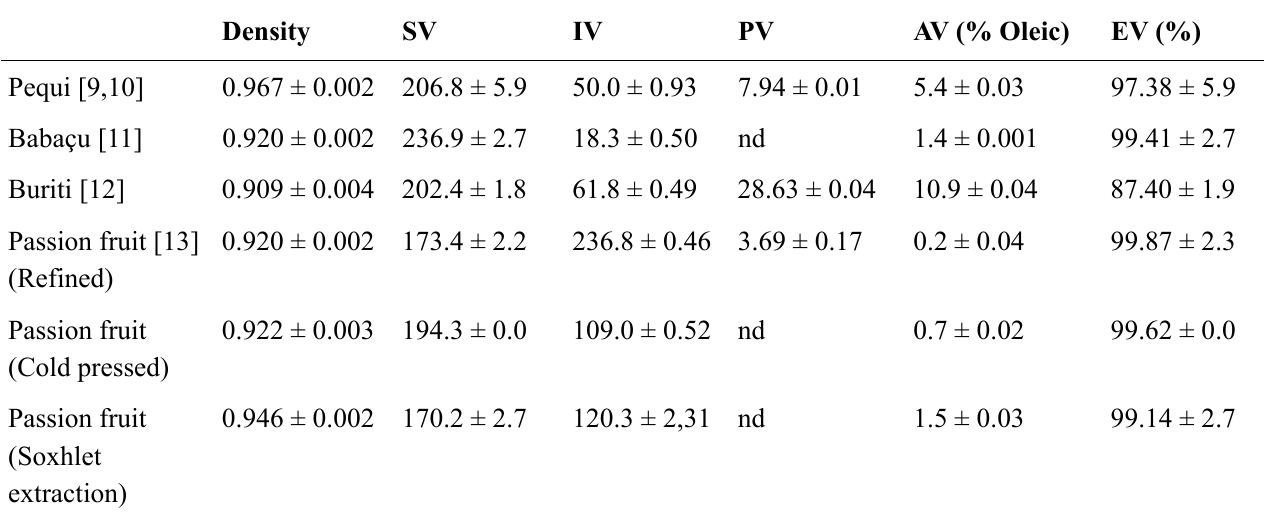
Table1. Physicochemical analysis.